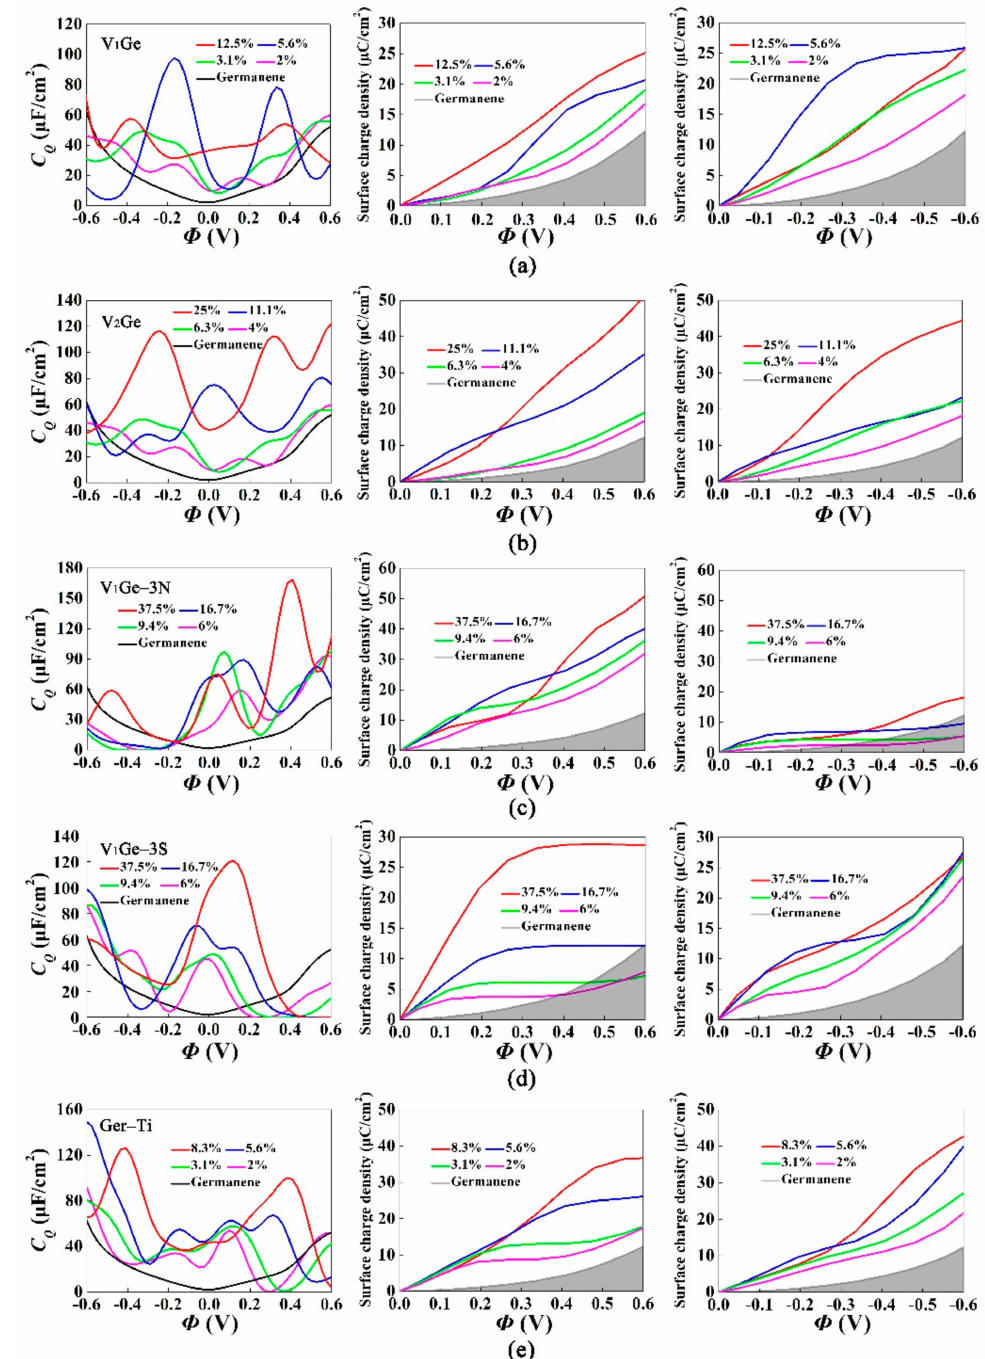
Figure 5. Calculated quantum capacitance (left) and surface charge density vs. potential drop ( − 0.6 V~0.6 V) with different concentrations of ( a ) single-vacancy, ( b ) double-vacancy, ( c ) triple- N doped with single-vacancy germanene, ( d ) triple-S doped with single-vacancy germanene and ( e ) pristine germanene adsorbed Ti at the most stable